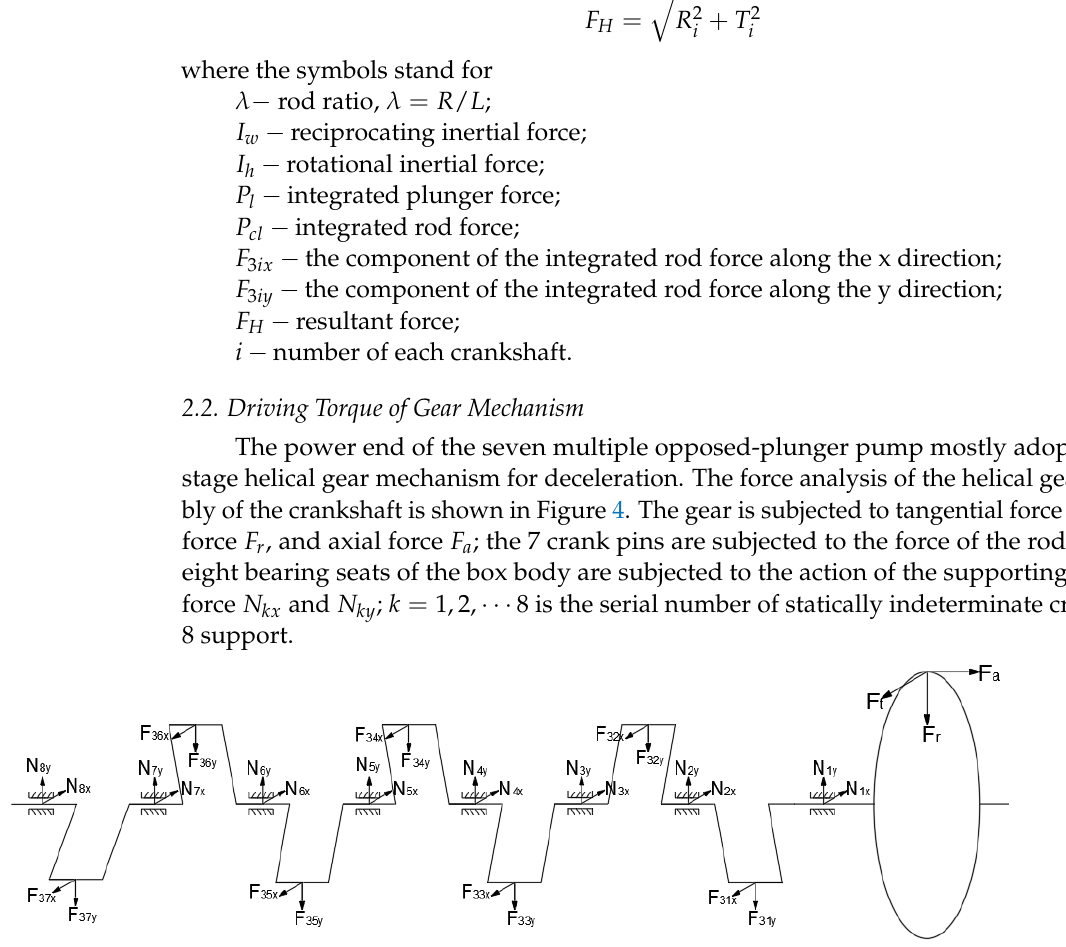
Figure 4. Force analysis of the crankshaft.